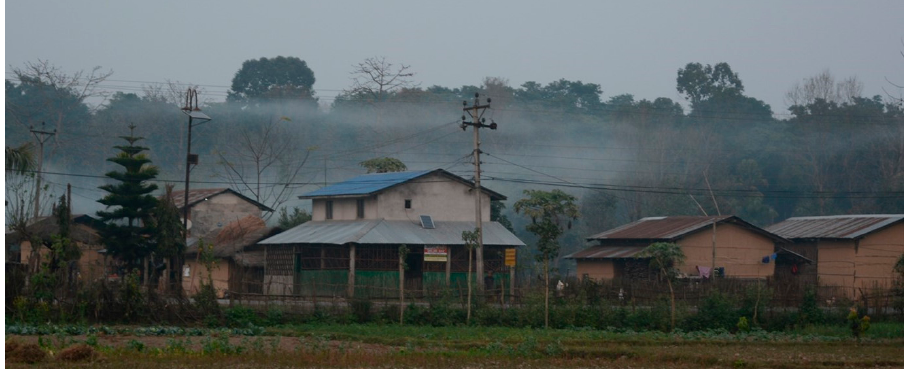
Figure 1. Smoke layer in a village due to cookstove emissions (Photo: Arnico K. Panday, ICIMOD; http://www.icimod.org/?q=35075).